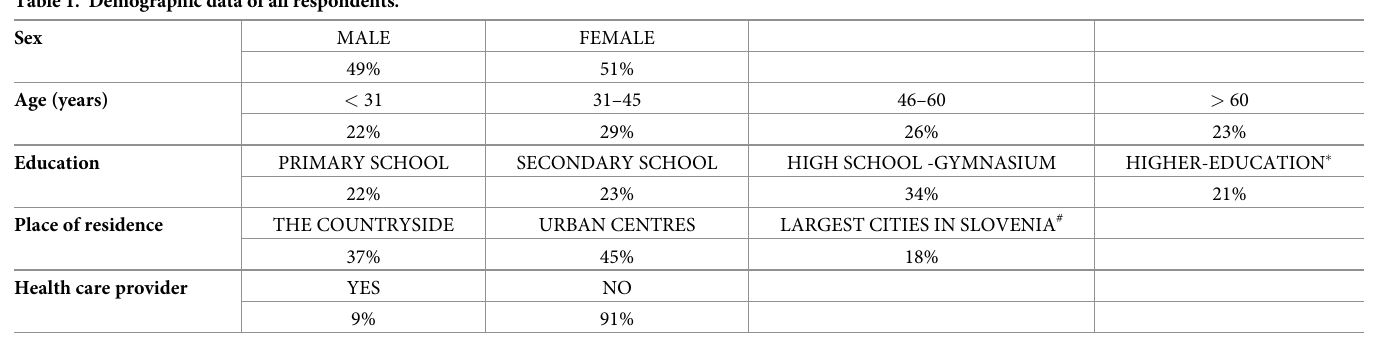
Legend: � B3–1 st and 2 nd or 3 rd cycle of Bologna. #Ljubljana (approximately 280000 inhabitants), Maribor (approximately 94000 inhabitants).